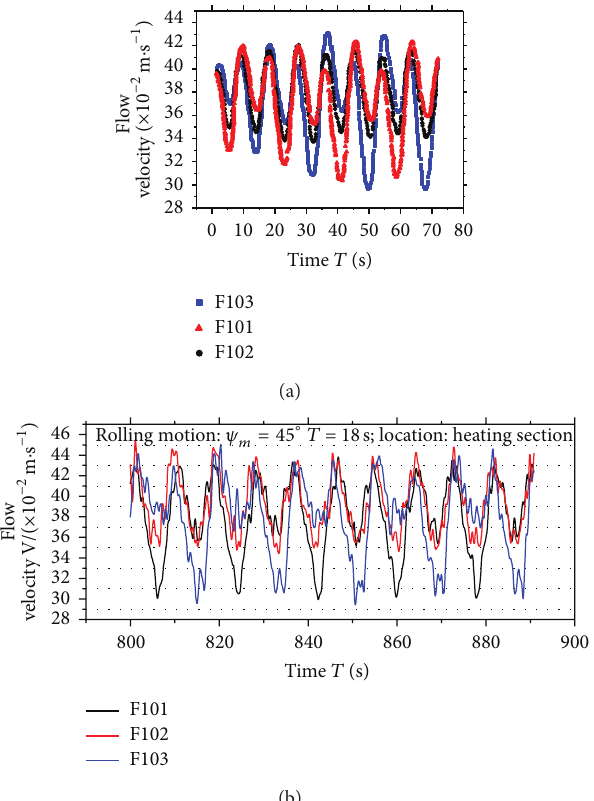
Figure 4: Comparison of experimental results and calculated results of rolling motion with swing angle 𝜓 𝑚 = 45 ∘ and rolling cycle 𝑇 = 18 s in full power condition: (a) calculated result; (b) experimental